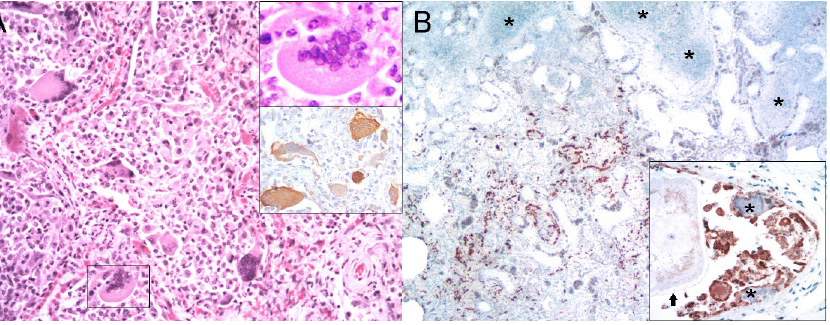
Fig 4. Cetacean morbillivirus-associated lesions and comorbidities in lung of striped dolphins ( Stenella coeruleoalba ), bottlenose dolphins ( Tursiops truncatus ) and Guiana dolphins ( Sotalia guianensis ). (A) Lung (Case 19). Detail of severe inflammation of alveolar spaces and septa with numerous multinucleate giant cells/syncytia (MGCS). Right upper inset: MGCS lining an alveolar septum. 400x. H&E. Right lower inset: pancytokeratin-positive MGCSs lining alveolar septa. 200x. IHC for AE1/AE3. (B) Lung (case 3). Morbilliviral labeling in areas adjacent to occlusive bronchiolar fungal masses (asterisks). 40x. IHC for CeMV. Inset: Epithelial and MGCS labeling in a bronchiole with lamina propria mineralization (asterisks) and luminal adult H . brasiliensis (arrow). 400x. IHC for